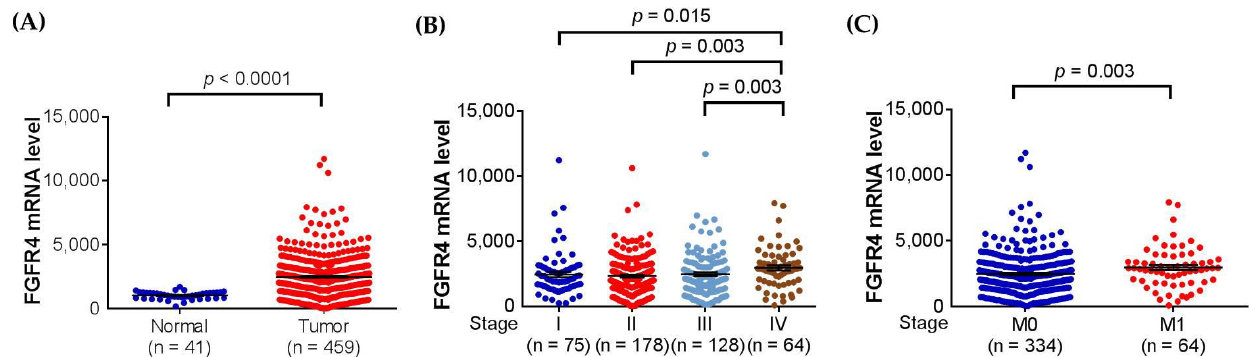
Figure 2. FGFR4 expression levels are associated with clinicopathological parameters in colon adenocarcinoma. Correlations of increased FGFR4 expression with the ( A ) occurrence, ( B ) advanced stage (stage IV), and ( C ) distal metastasis of colon adenocarcinoma from The Cancer Genome Atlas (TCGA) database. p -Values are calculated with Student’s t test and adjusted by using Bonferroni correction.